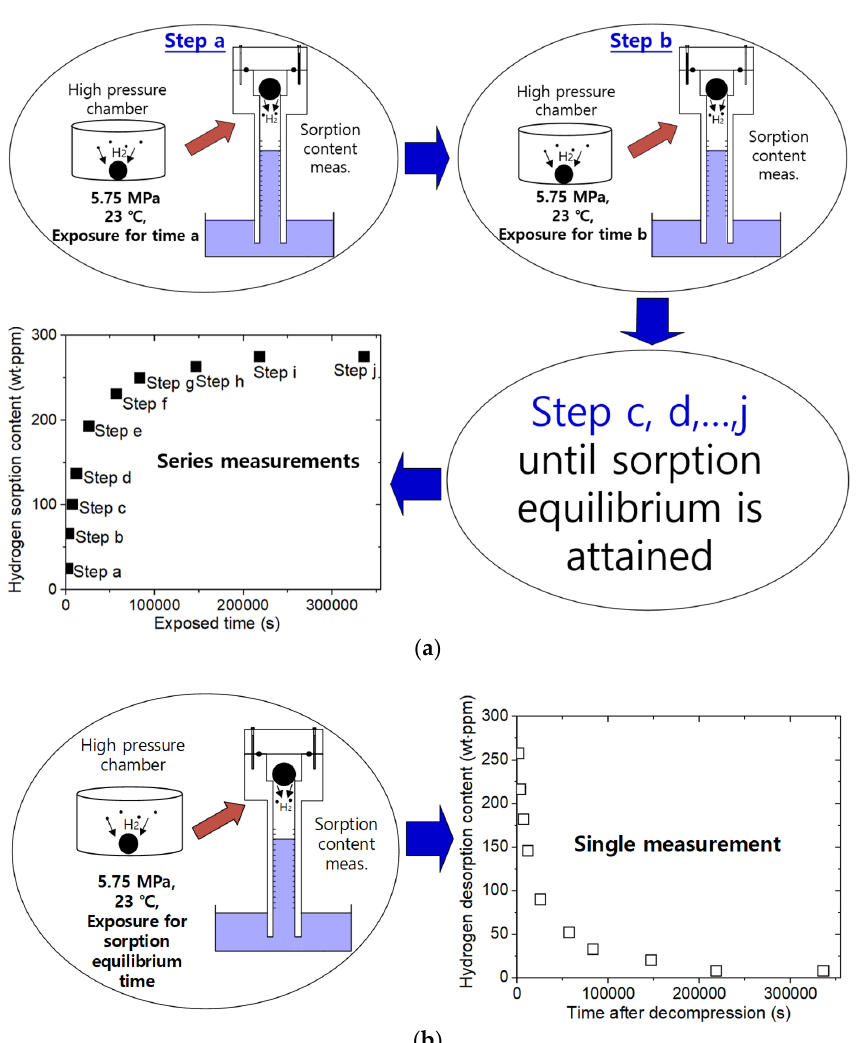
Figure 2. ( a ) A clockwise procedure for measuring sorption properties. ( b ) Procedure for measuring desorption properties. The measurement was performed after loading the cylinder for the specimen’s exposure to the HP